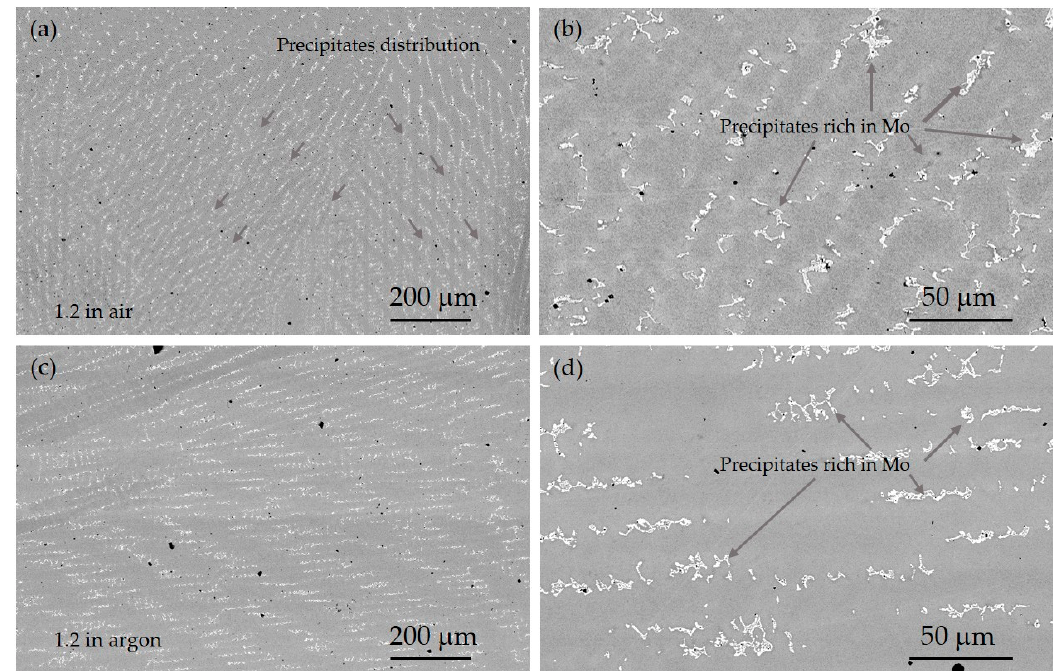
Figure 9. CBS-SEM images of Hastelloy C-22 specimens manufactured without thermal treatment ( a ) and ( b ), and in air ( c ) and ( d ) argon.